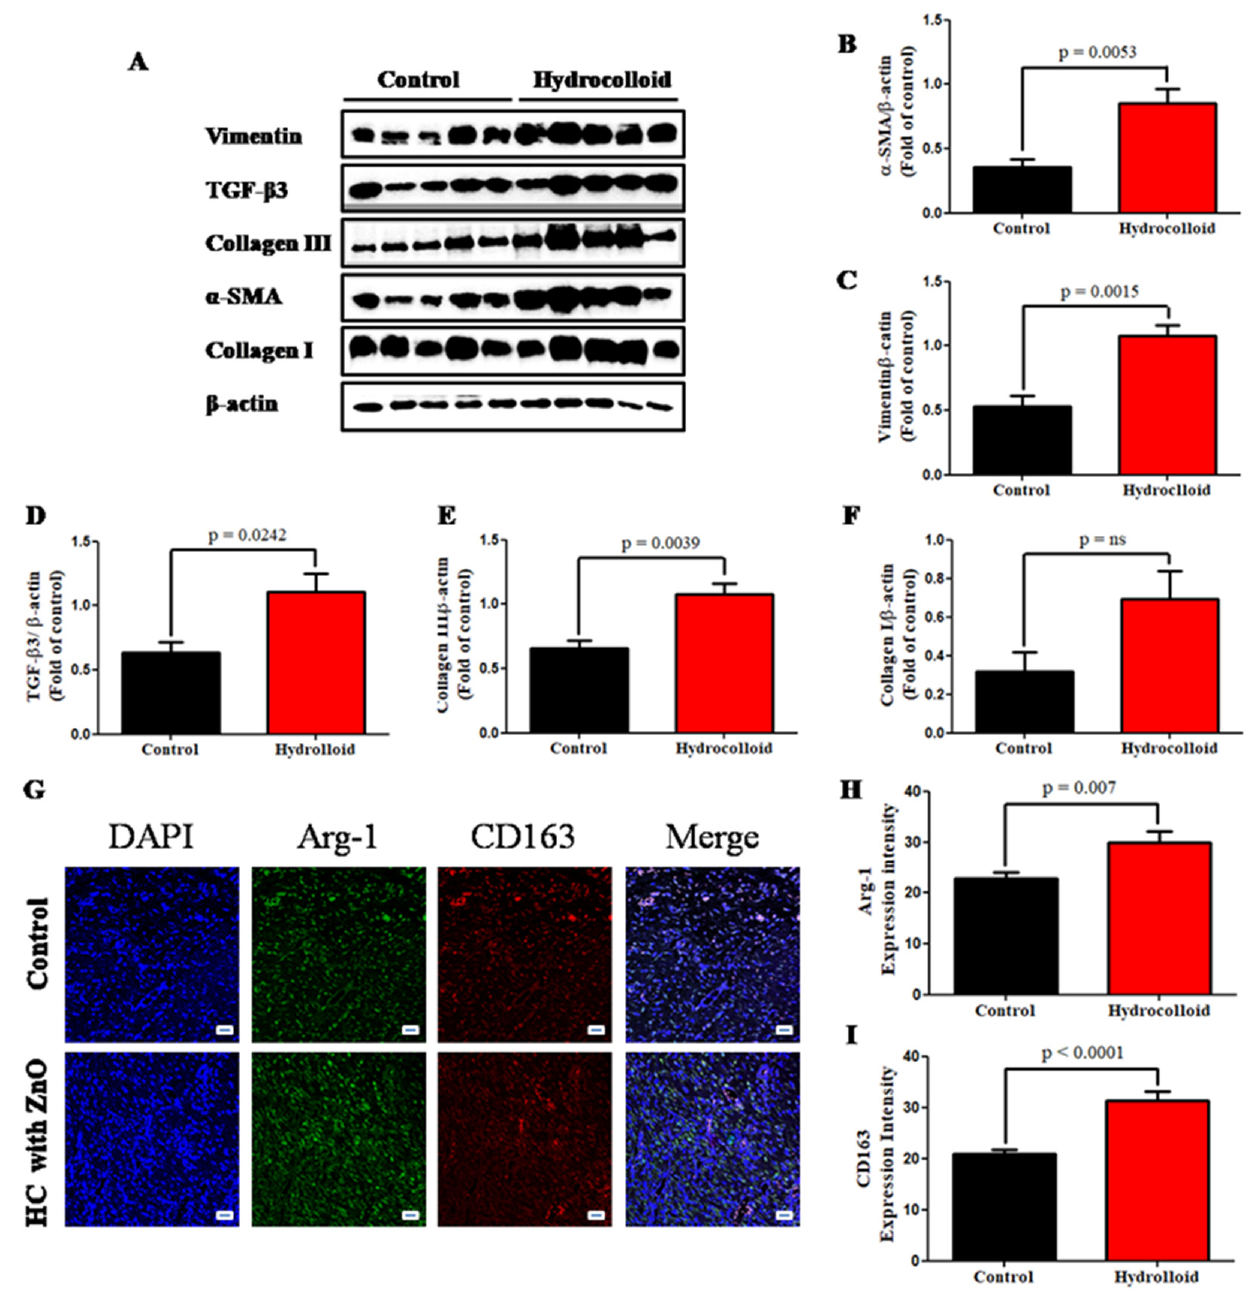
Figure 5. A hydrocolloid patch covered with ZnO nanoparticles accelerates proliferative phases and increases the proliferative responses of wound healing. ( A ) Representative images of Western blotting. Quantitative densitometry analysis of proliferative response expression. ( B ) Alpha smooth muscle actin, α -SMA. ( C ) Vimentin. ( D ) Transforming growing factor-beta 3, TGF- β 3. ( E ) Collagen III. ( F ) Collagen I. ( G ) Fluorescent micrographs showing cytokine staining of macrophage 2 on day 10 of the wound healing process. The quantitative density gap of macrophage 1 antigens of the two groups on day 10. ( H ) Arginase 1, Arg-1. ( I ) CD163. Scale bars are 50 µ